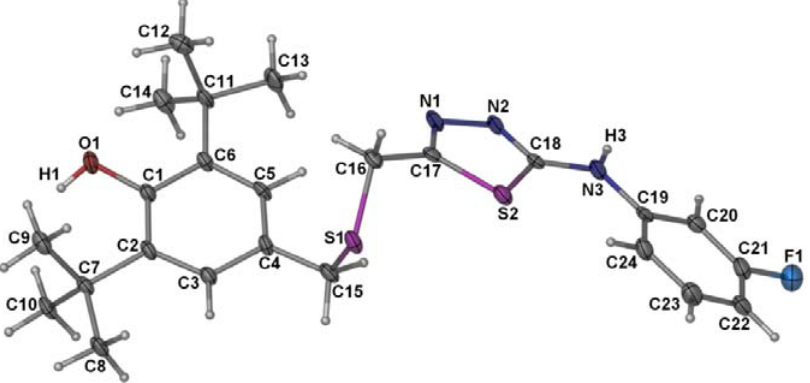
Figure 5. The molecular structure and labeling scheme of 4 (50% probability